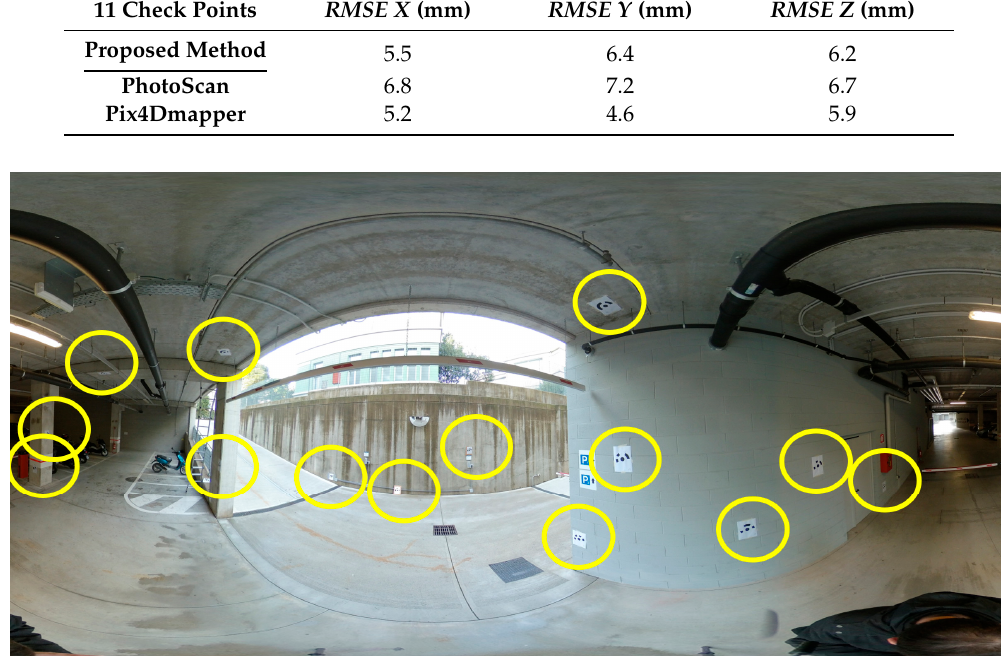
Table 1. Comparison between the proposed method and commercial software. RMSE, root mean square error.